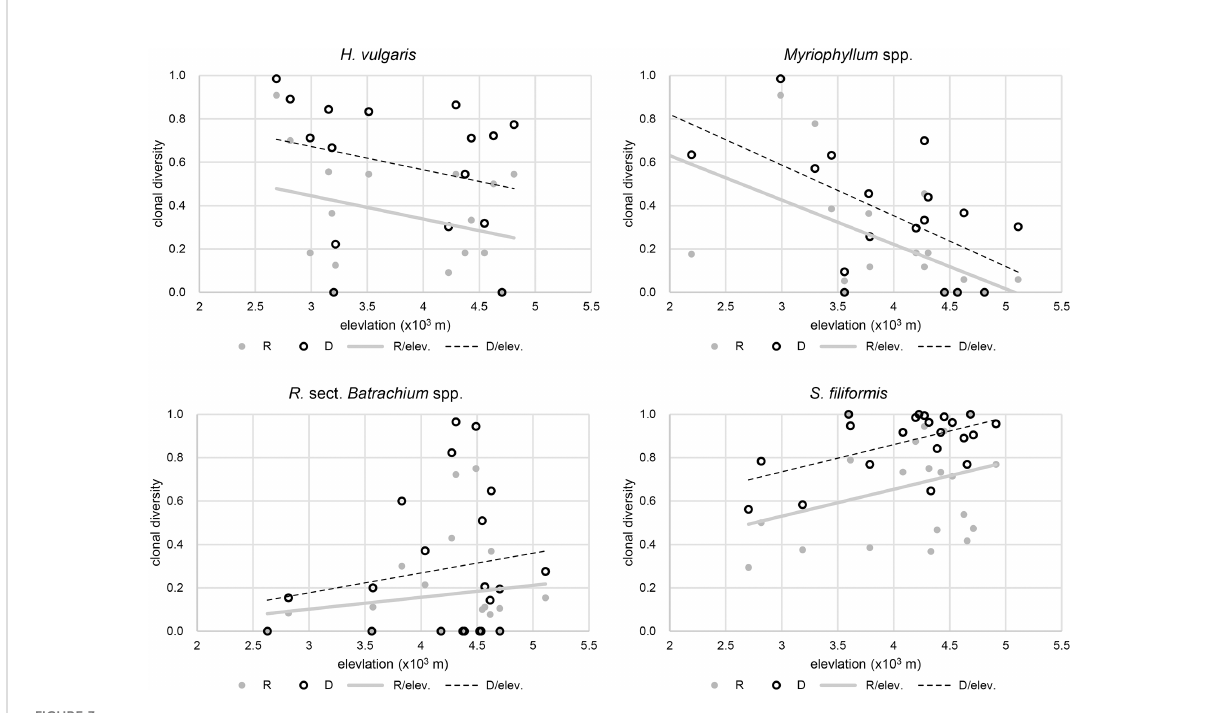
FIGURE 3 Correlation between clonal diversity and elevational gradient.